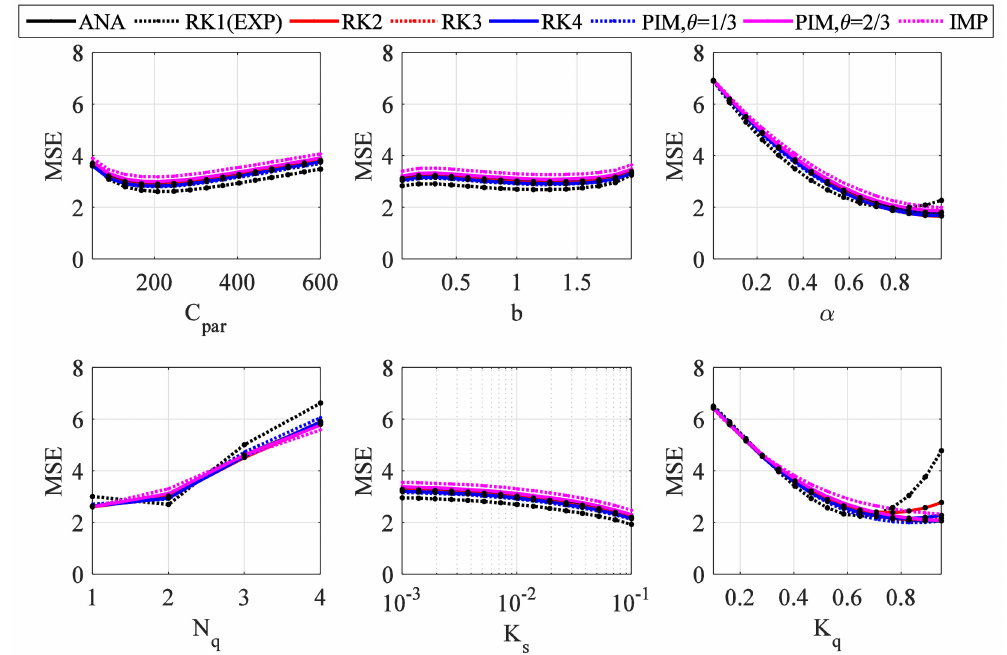
Figure 5. One-dimensional sensitivity analysis (1DSA) of the mean square error (MSE) with different numerical schemes for the six parameters in